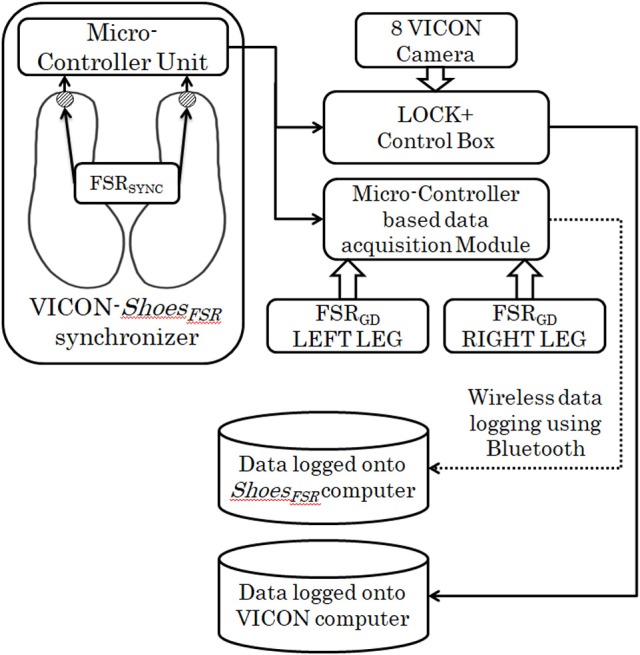
Block Schematic of VICON-ShoesFSR synchronizer.